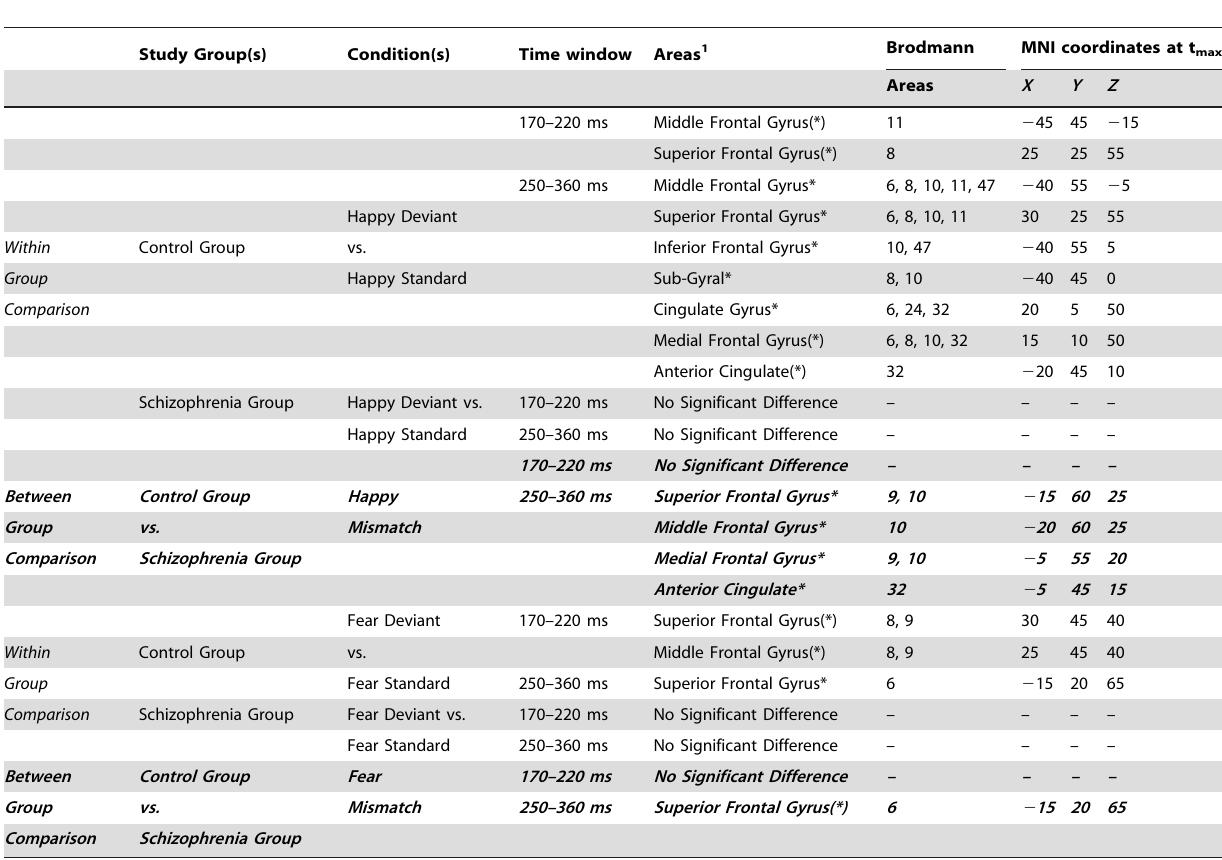
Table 4. Source Localization of the Mismatch Signals.